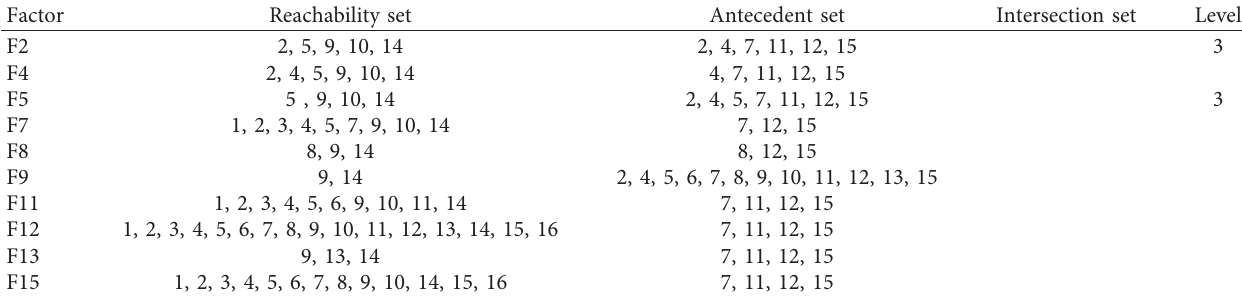
Table 6: Level partitions for level 3.